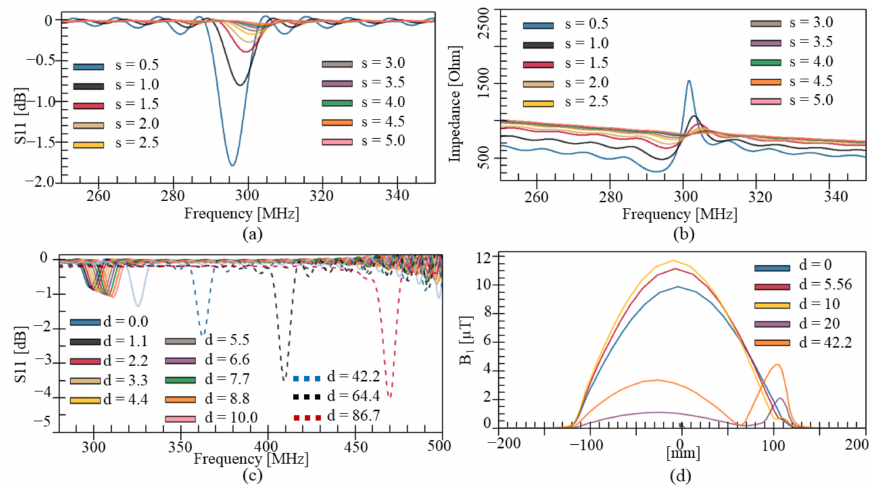
Figure 2. The effects of the microstrip line to different gap size, ( a ) the S11 parameters and ( b ) the impedance. The effects of moving the gap along the microstrip, ( c ) the S11 parameters and ( d ) the |B 1 | field profile along the